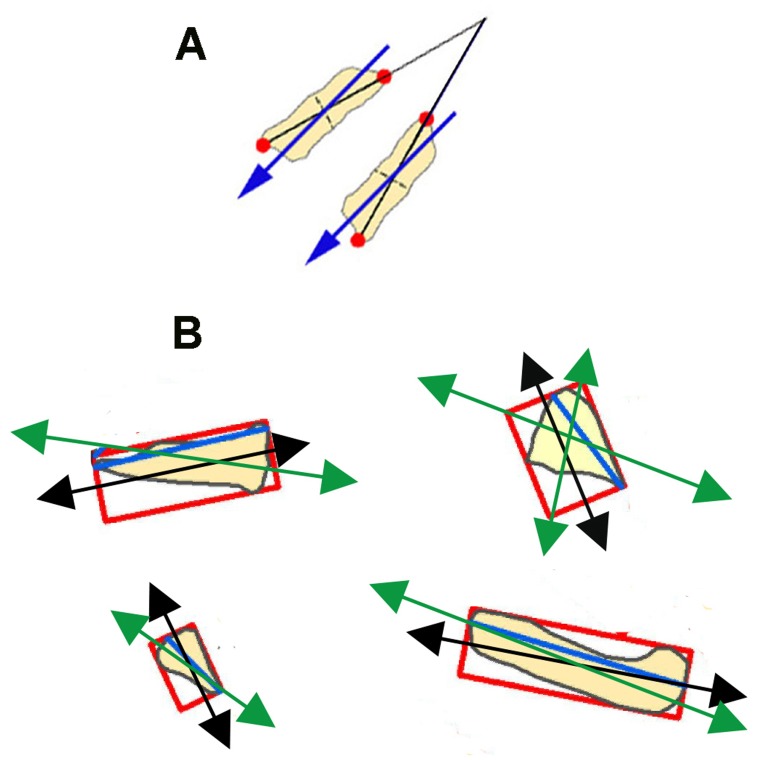
Comparison of different A-axis types.A, Contrast in orientation between DPA [1] and SLA (blue arrows). Notice how two parallel specimens with identical longitudinal axes (SLA) show divergent DPA of 30°. B, Some examples from [14] showing MBRA (black arrows), DPA (blue lines) and SLA (green arrows). Notice the divergent angles.